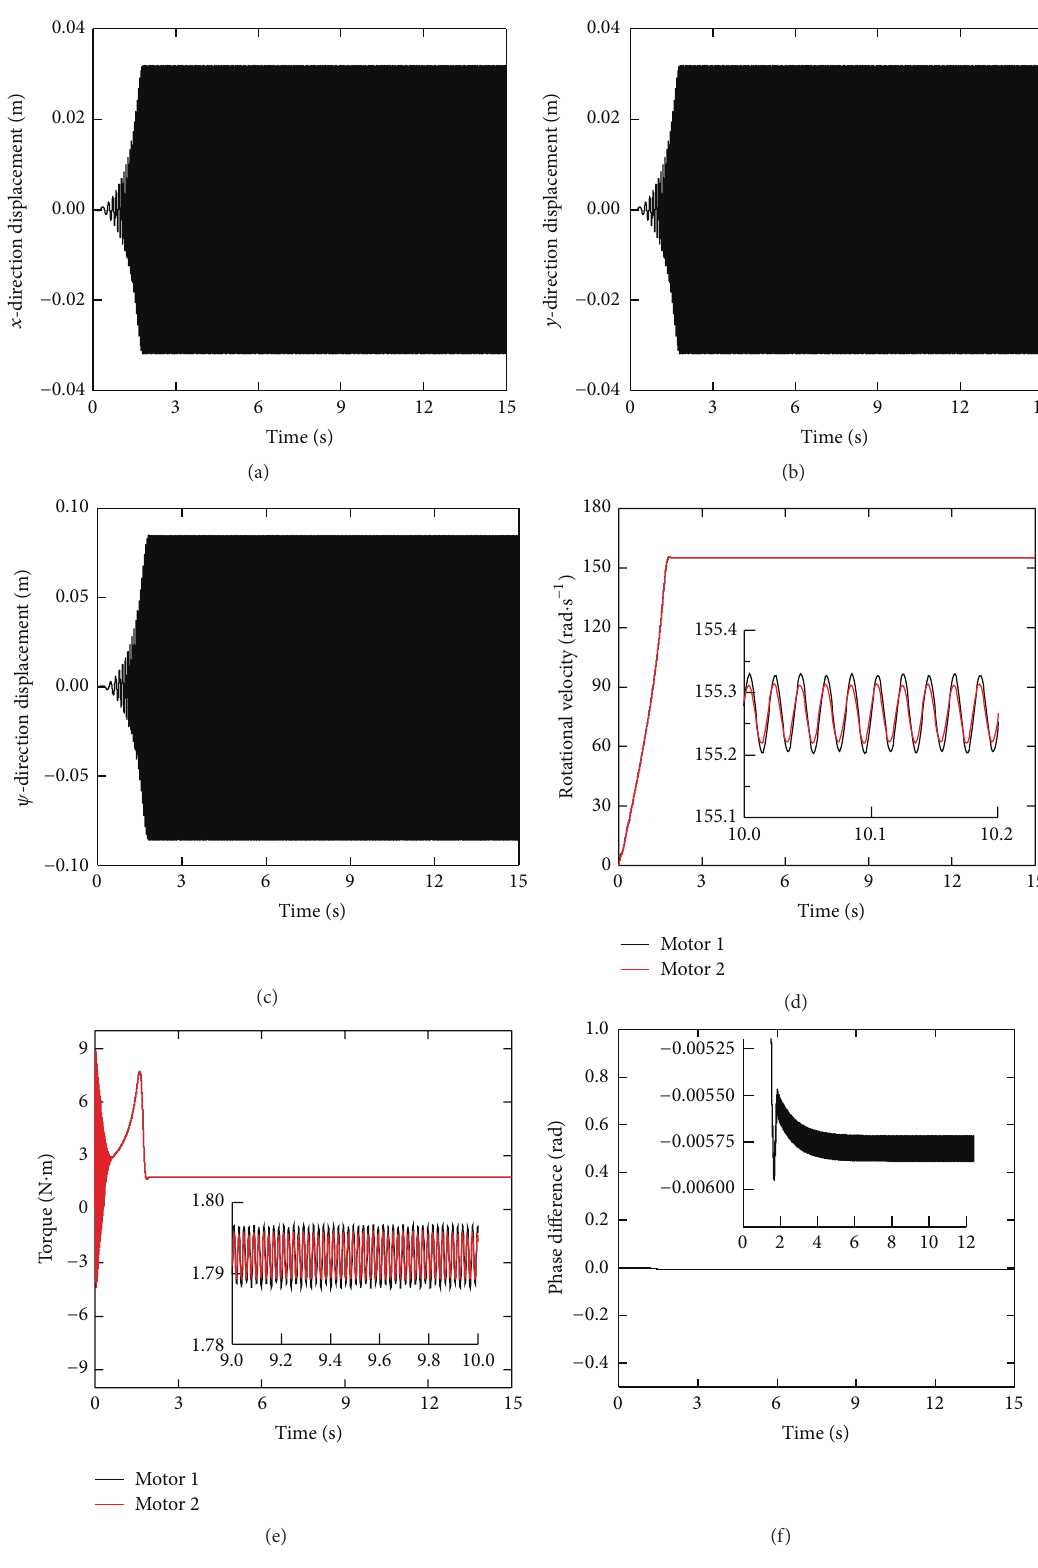
Figure 5: Results for the computer simulation: (a), (b), and (c) displacement responses of the vibrating body in 𝑥 - , 𝑦 - , 𝜓 -directions, respectively; (d) rotational velocities of the two rotors; (e) electromagnetic torques of the two rotors; (f) phase difference of unbalanced